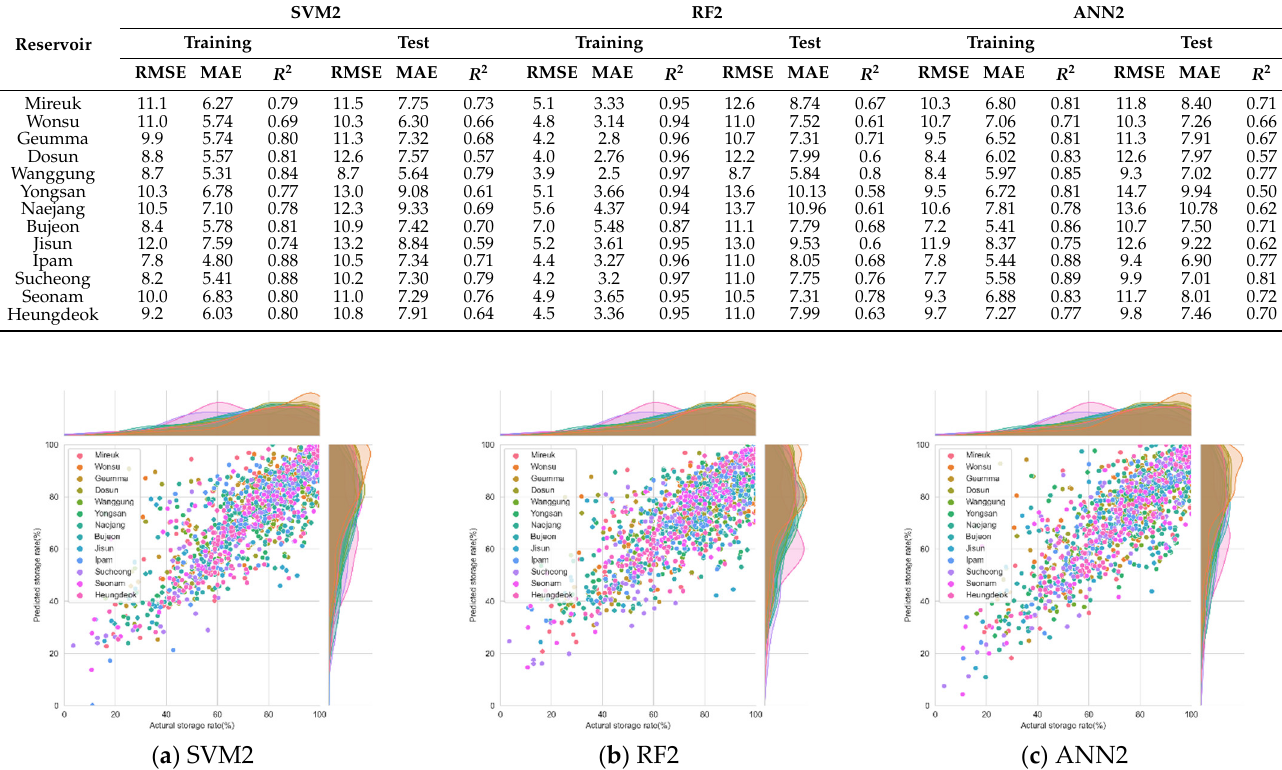
Figure 5. Scatter plots of the observed and predicted monthly storage rates using ( a ) SVM, ( b ) RF, and ( c ) ANN algorithms (two-month forecast). Table 8. Results of best parameters and learning time of models for two-month forecasting.